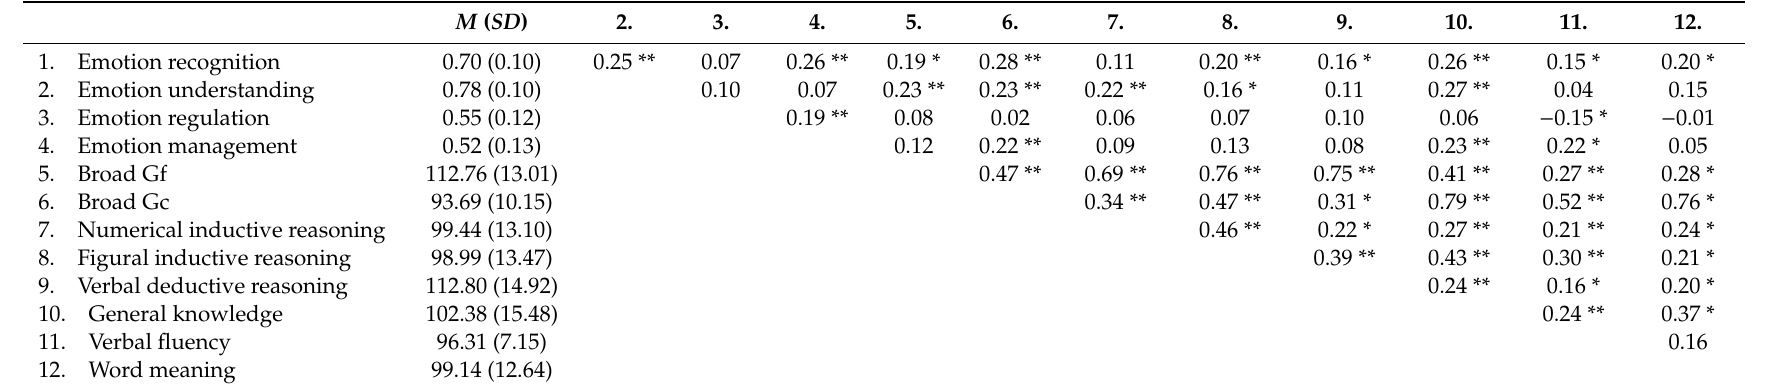
Table A1. Means, standard deviations and correlations of emotional and cognitive ability scores.